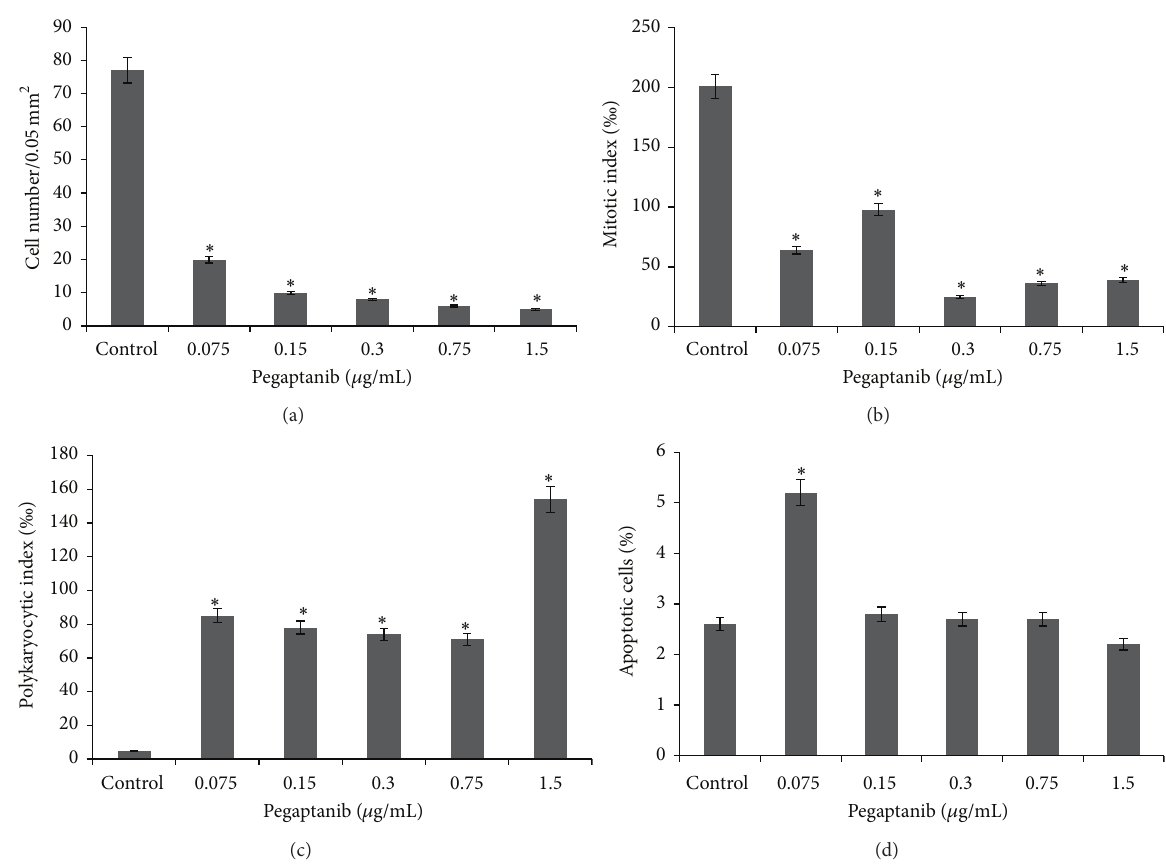
Figure 6: Kinetics of cellular proliferation (a), mitotic activity (b), polykaryocytic index (c), and apoptosis (d) in L929 cells treated by pegaptanib at different concentrations (data shown are at Day 5 of the treatment; 𝑛 = 3 , ∗ 𝑃 < 0.05